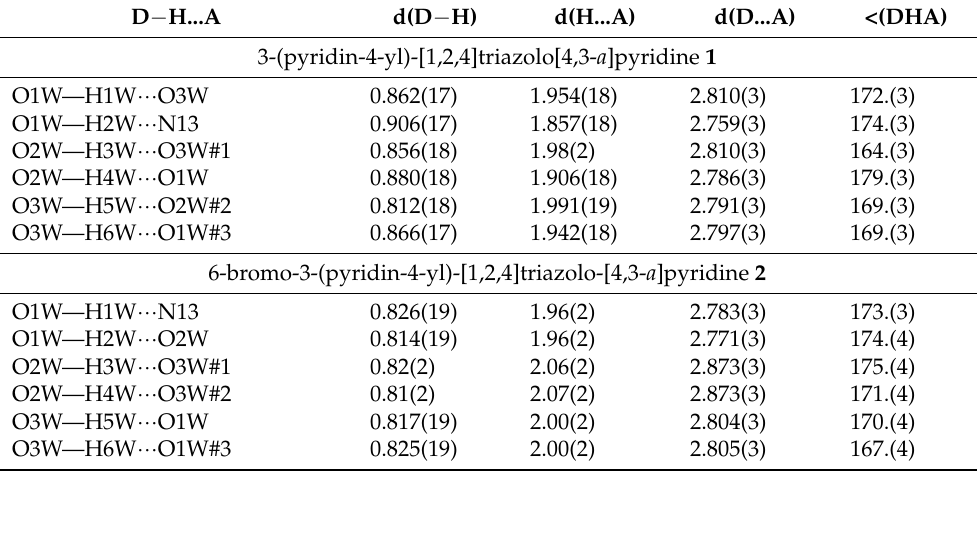
Table 3. Hydrogen-bond parameters (Å) for compounds 1 and 2 .